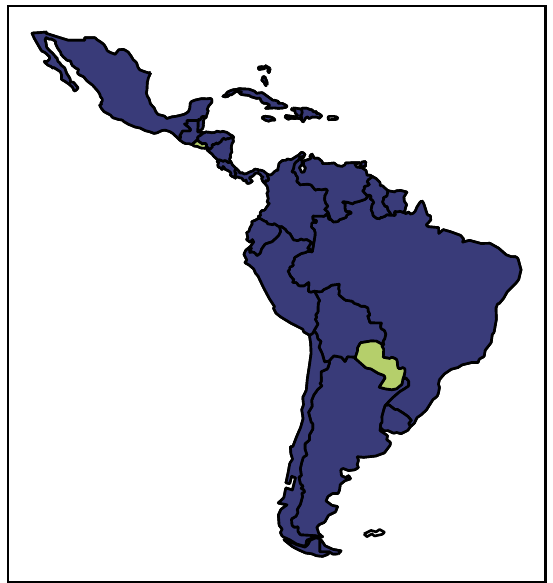
Figure 15. A map portraying the income groups of the most frequent collaborators of South and Central American nations. Nations colored in blue most frequently collaborate with high-income group nations, nations in green most frequently collaborate with upper-middle-income group nations, nations colored in red most frequently collaborate with lower-middle-income group nations, and nations colored in white did not have publications in the data set.